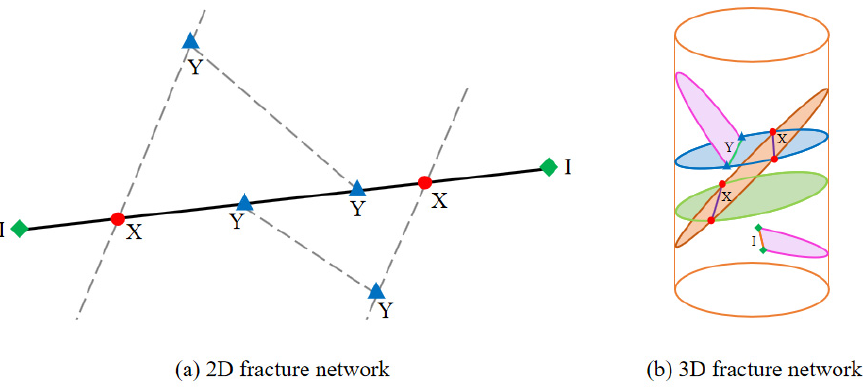
Figure 5. Fracture networks in two-dimensional ( a ) and 3D with three types of nodes: I-nodes; Y-nodes; X-nodes ( b ).